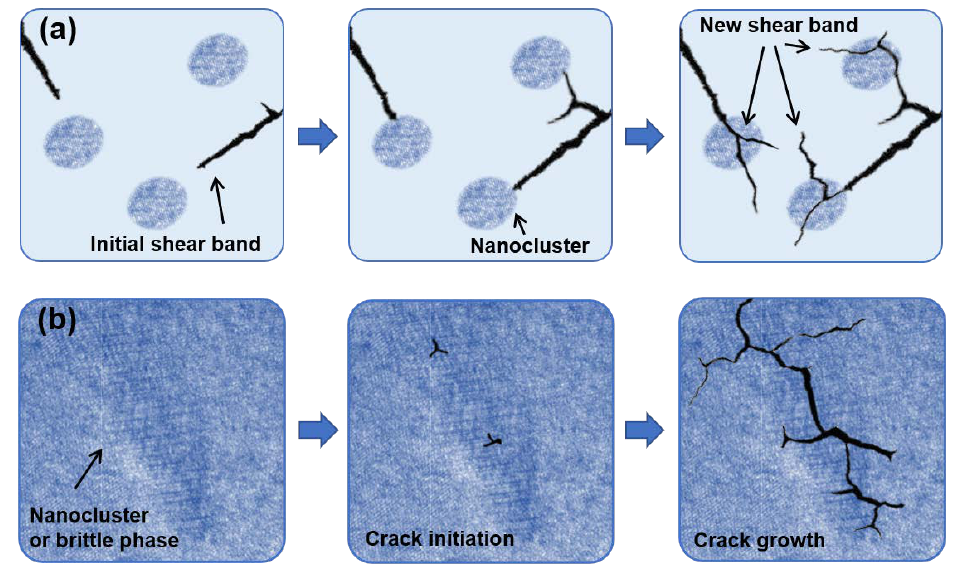
Figure 7. Schematic diagram of the effect of nanoclusters on shear bands and cracks: ( a ) Nanoclusters hinder propagation of shear bands; ( b ) Nanoclusters or brittle phase promote initiation and expansion of cracks.